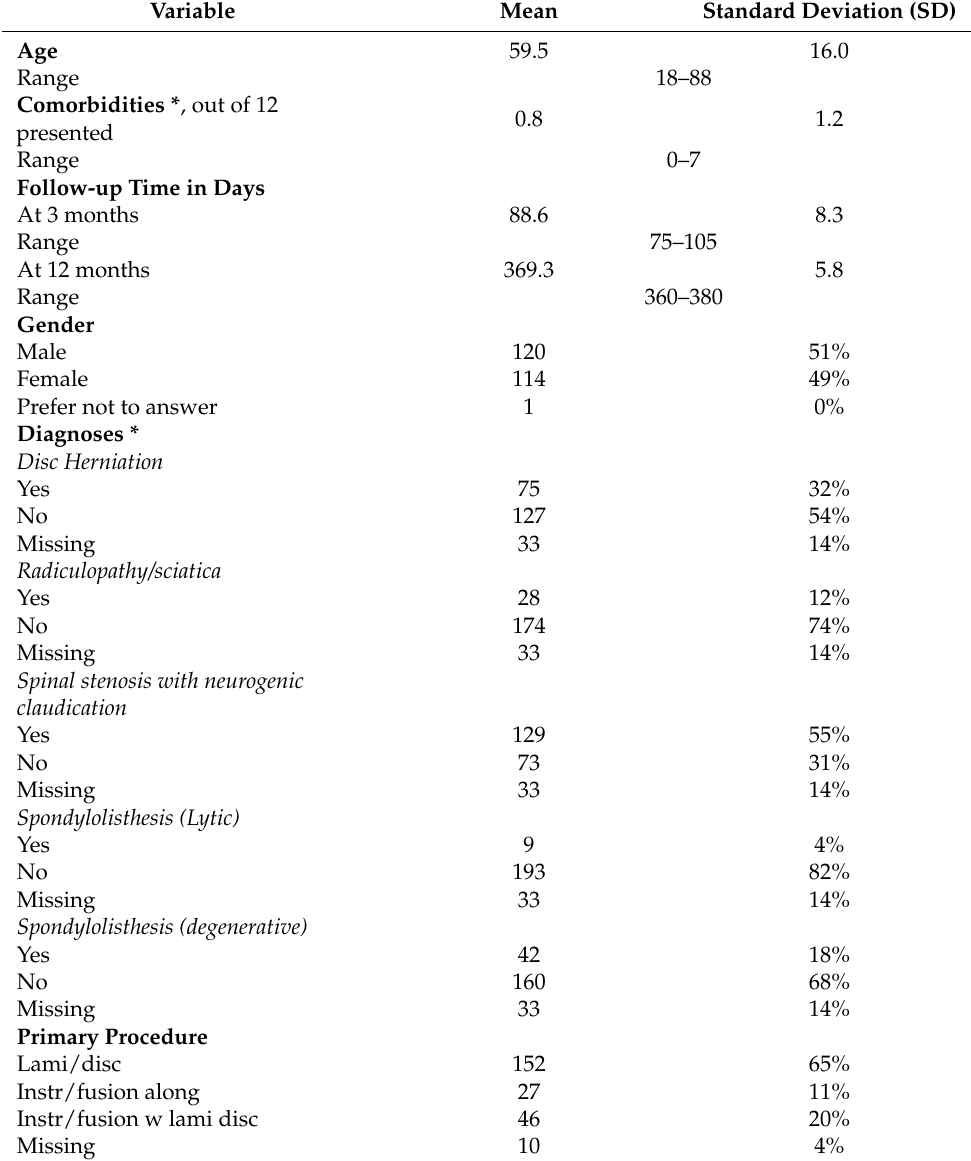
Table 1. Descriptive Statistics of Study Sample † (N =